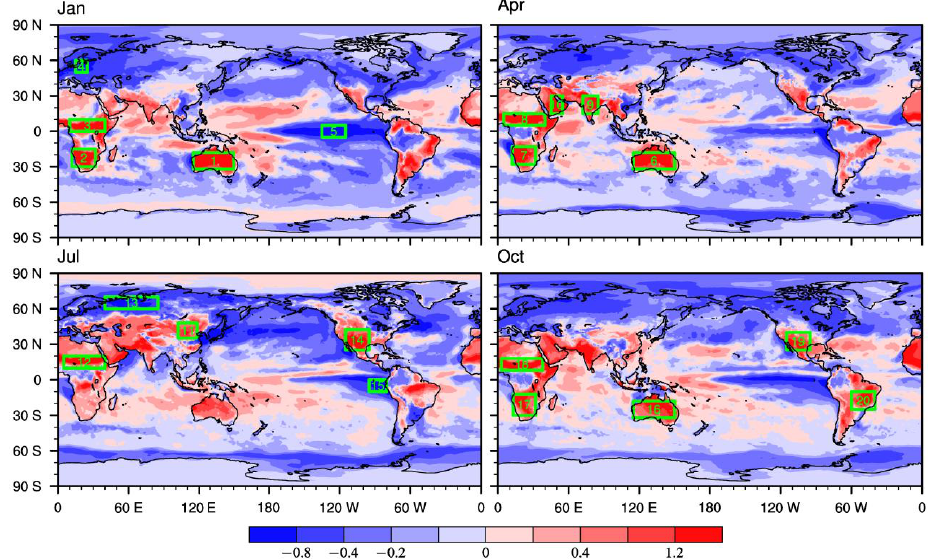
Figure 7. Distribution of the difference from S R – S T . The unit is hPa. The 20 areas, with 5 for each of the four months, are major positive (red) and negative (blue) centers and are selected for use in Section 8 and Table 1. Table 1. The interannual correlations between the precipitation P and surface vapor pressure E (r1), the P and surface-air temperature T (r2), the E and T (r3), and the E and surface relative humidity R (r4). These quantities are averaged over the 20 areas selected in Figure 7 for the four months. For the 43-year variations, the correlation coefficient at the 0.05 significance level is 0.294. The values of the precipitation averaged over the area and over the month of the 43 years ( P , mm/day) are also provided. For precipitation, while using the ERA5 reanalysis, the CMAP data is also utilized. In the columns of r1, r2, and P, the results from the CAMP precipitation are given in parentheses. The correlations that are significant at the 0.05 level are highlighted in bold font. The serial number of two oceanic areas are marked as blue and those of the two high-latitude areas are marked as red. Serial Number r1 ( P , E